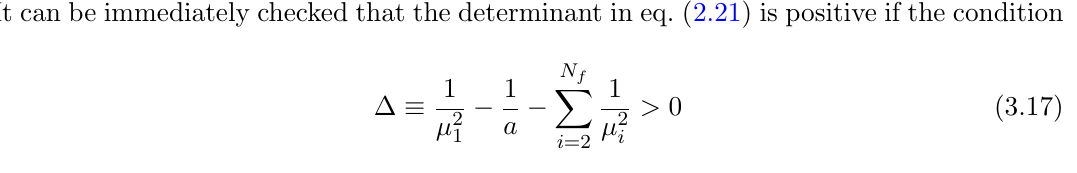
is found to lie O(( (cid:22) 2 =a ) 2 ) below the CP conserving one. The existence of this